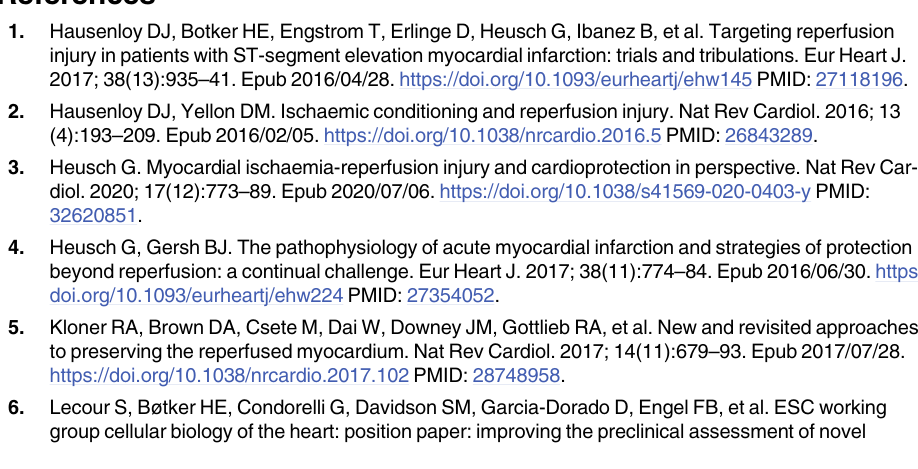
S6 Fig. Full unedited blots for Fig 2. Blots were probed using antibodies against tyrosine- phosphorylated STAT3 (P-STAT3), STAT3, phosphorylated AKT (P-AKT), AKT, phosphory- lated ERK (P-ERK1/2), and GAPDH. S7 Fig. Full unedited blots for Fig 4. Blots were probed using antibodies against tyrosine- phosphorylated STAT3 (P-STAT3), STAT3, phosphorylated AKT (P-AKT), AKT, phosphory- lated ERK (P-ERK1/2), and GAPDH.